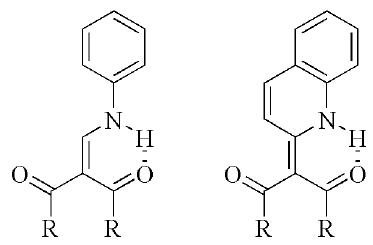
Figure 2. N -(2,2-diacylvinyl)anilines and 1,2-dihydro-2,2-diacylmethylenequinolines.